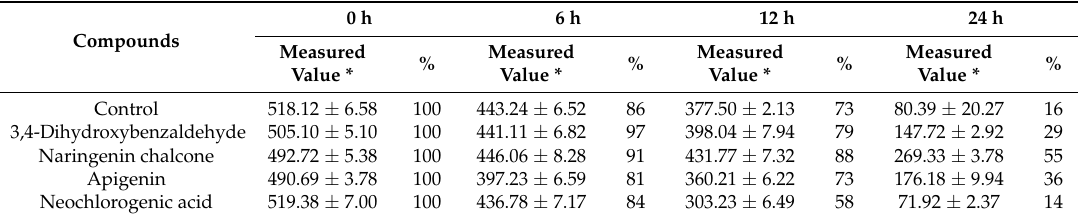
Table 2. Results of the scratch test for 22RV1 cells.